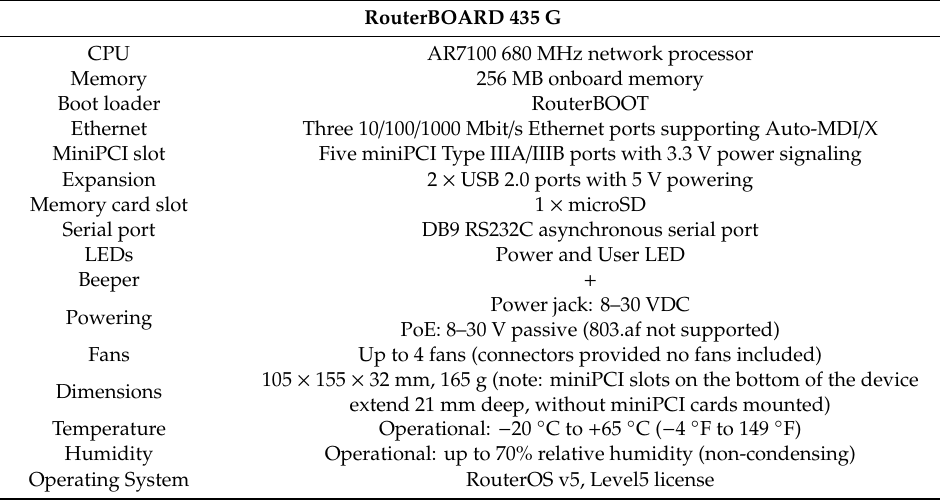
Table 8. Characteristics of the board RouterBOARD 435G.